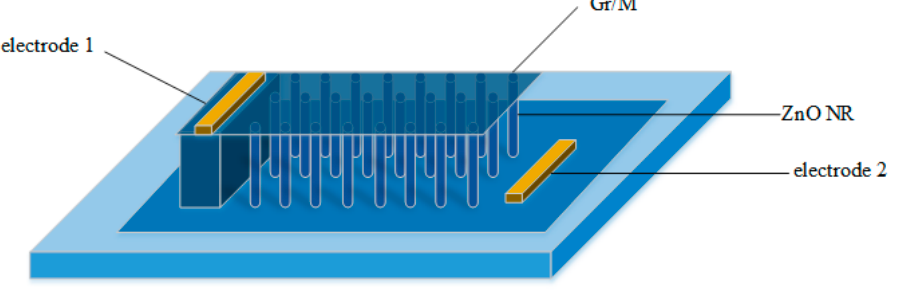
Figure 15. Schematic illustrating of the key steps for fabricating the ZnO NRs–Gr/M hybrid architectures [82]. architectures